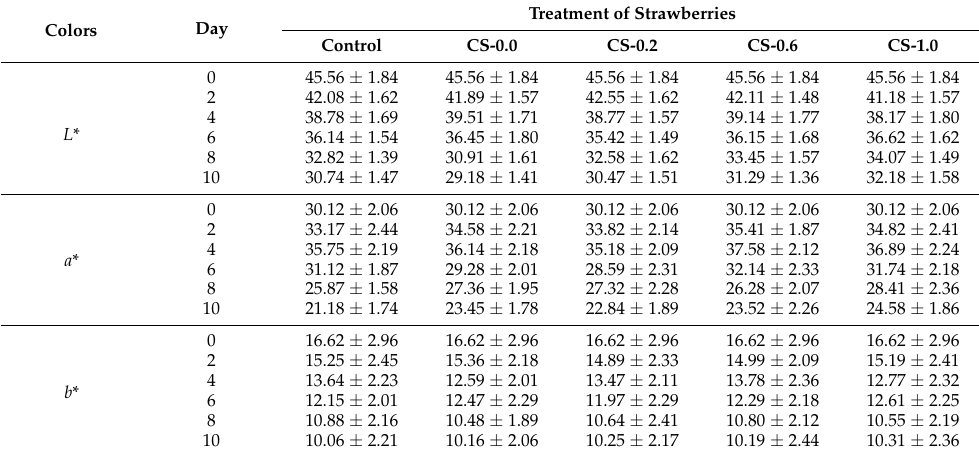
Table 3. The influence of CS films containing PFEO on the colors ( L *, a * and b *) of strawberries refrigerated at 4 ◦ C for 10 days a . Treatment of Strawberries Colors Day Control